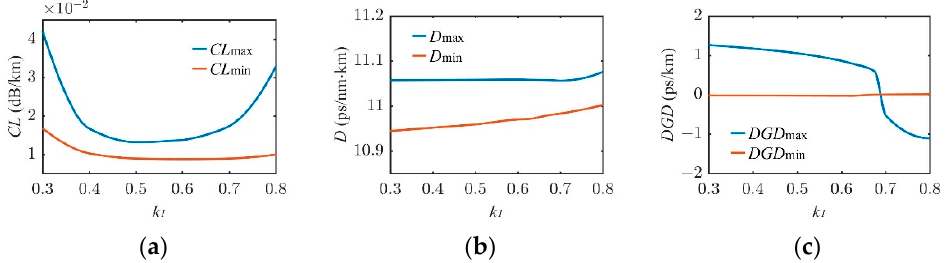
Figure 16. ( a ) Change in CL in the new structure with k 1 ; ( b ) Change in D in the new structure with k 1 ; ( c ) Change in DGD in the new structure with k 1 .